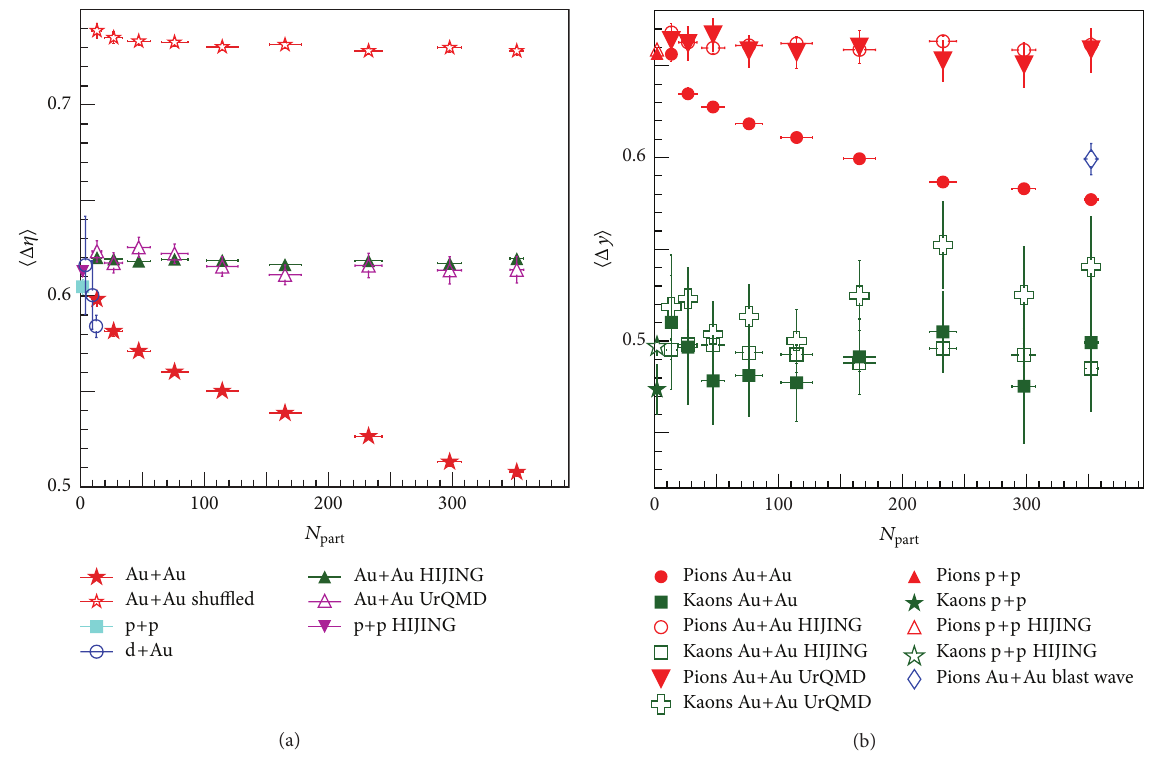
= 200 GeV compared with the widths NN = 200 GeV are also shown. Filtered NN